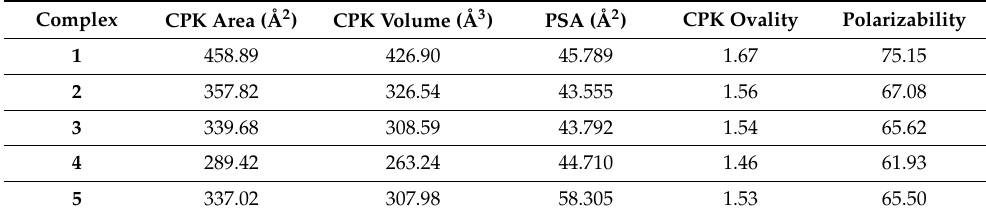
Table 10. QSAR parameters from CPK model as: CPK Area (Å 2 ), CPK Volume (Å 3 ), PSA (Å 2 ), CPK ovality, and polarizability from computed